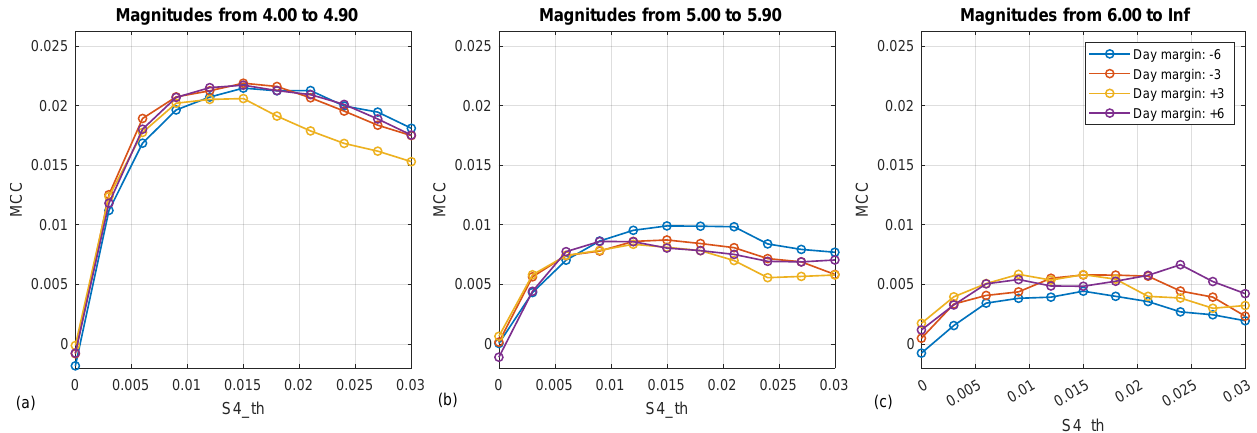
Figure 19. MCC values for two magnitude intervals using radius = 100 km with respect to the ∆ S 4 threshold: s 4_ th